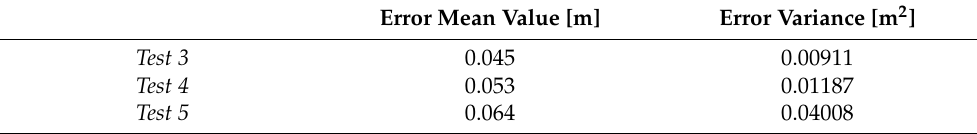
Table 4. Mean value and variance of the position estimation error in Test 3 , Test 4 , and Test 5 .